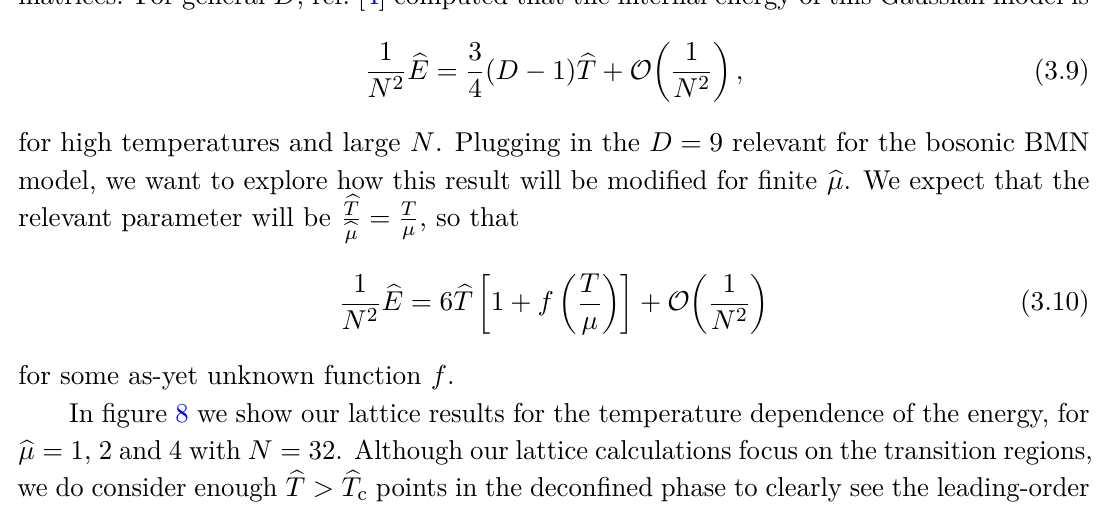
Figure 7. Signs that the phase transition is first order, for Polyakov loop magnitude has support across two different regions for b T developing two-peak structure. (b) Normalizing the Polyakov loop susceptibility by N 2 produces the same peak height for N = 16 and 32 , indicating that the maximum χ is scaling with the number of degrees of freedom ∝ N 2